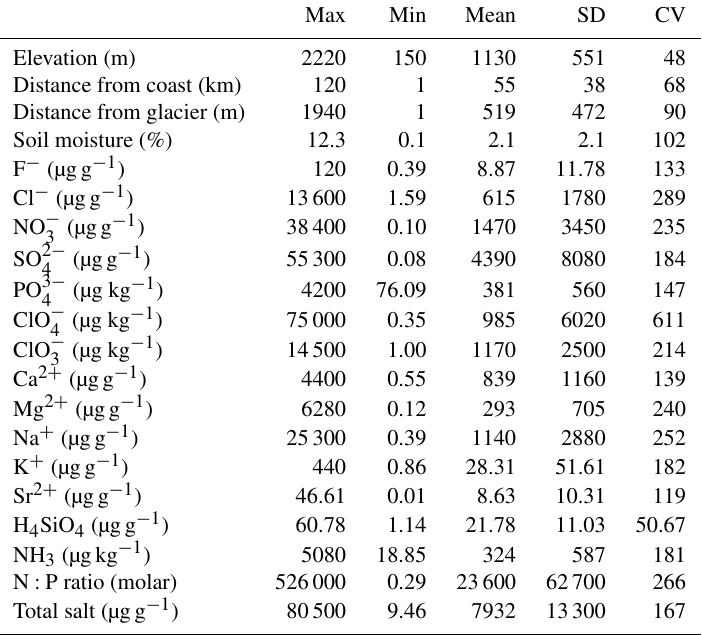
SD: standard deviation, CV: coefficient of